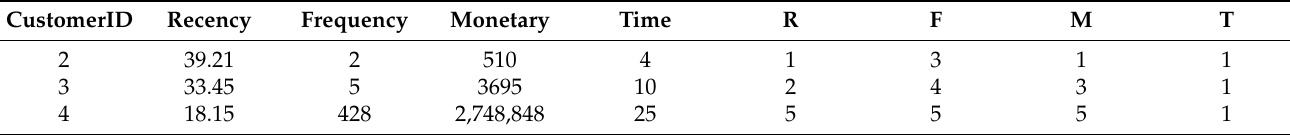
Table 1. Discretized scores example for the